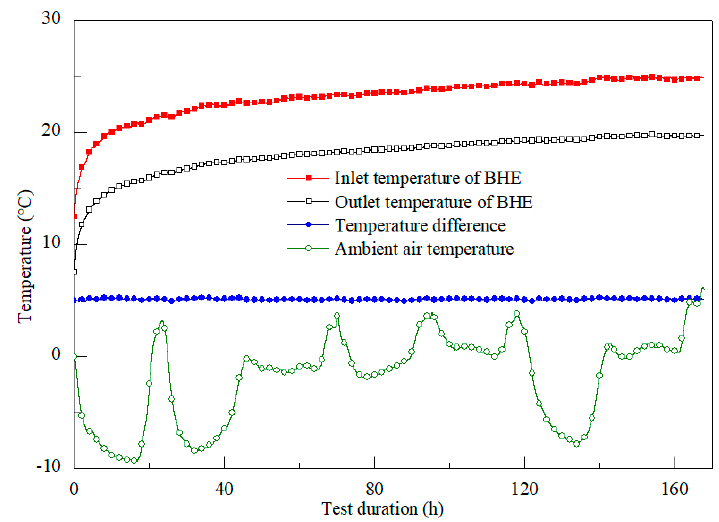
Figure 4. Tested temperatures. The figure shows the time evolution of the inlet and outlet temperatures of the BHE, their temperature differences, and ambient air temperatures. Table 1. Results of TRTPE using different models